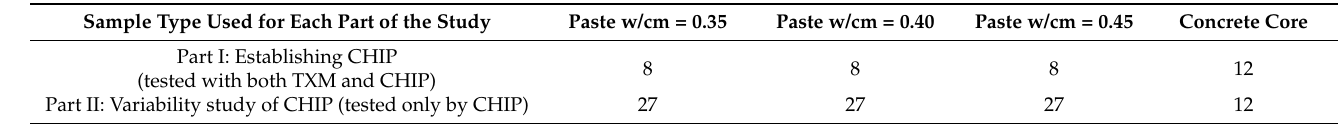
Table 1. Type and number of samples used in each part of the